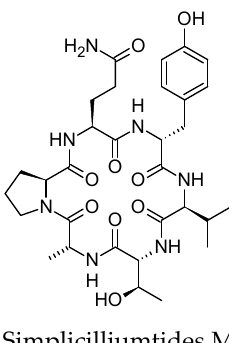
Figure 5. Recently isolated antiviral cyclic peptides.